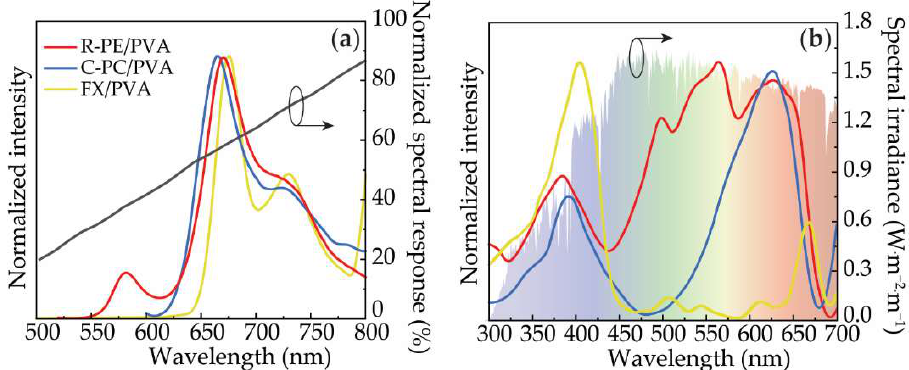
Figure 2. ( a ) Emission spectra for R-PE/PVA, C-PC/PVA, and FX/PVA excited at 498, 575, and 405 nm, respectively. The c-Si spectral response is shown on the right y -axis. ( b ) Excitation spectra for R-PE/PVA, C-PC/PVA, and FX/PVA monitored at 720 nm. The shadowed area represents the AM1.5G solar spectrum (right y -axis).